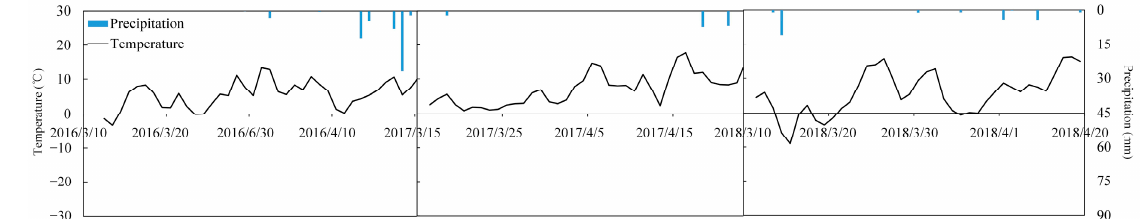
Figure 3. Temperature and precipitation during the thawing period of frozen